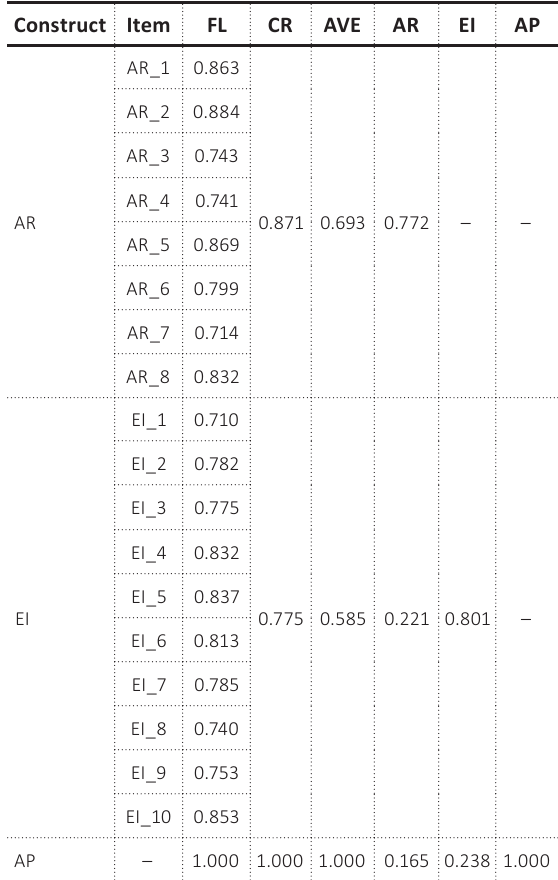
Table 1. Measurement model results